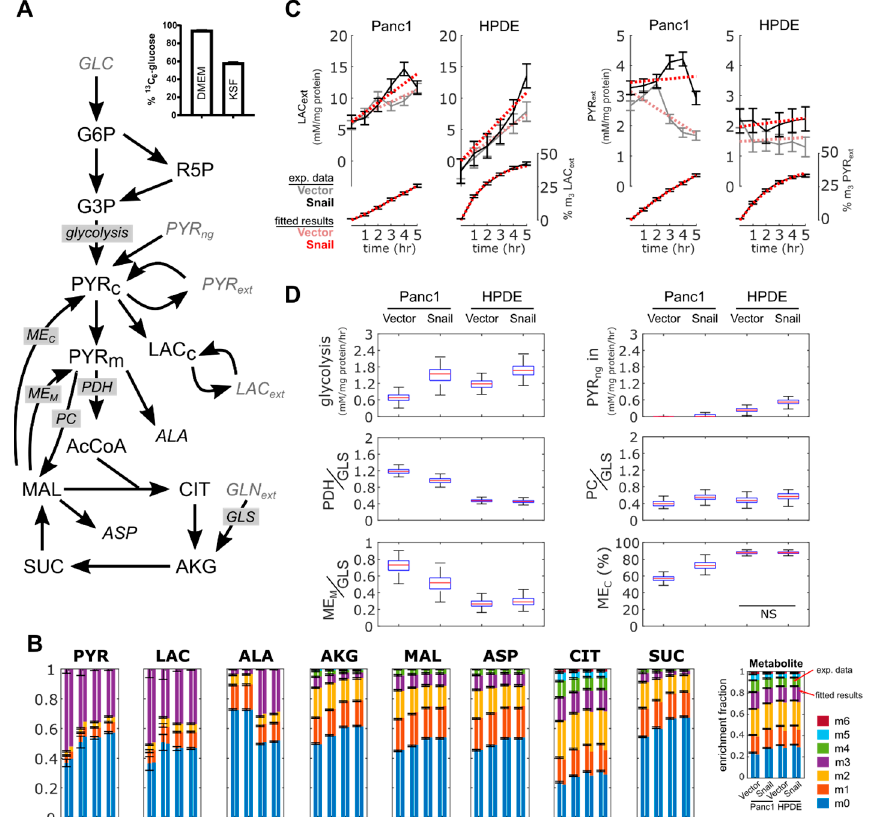
Figure 6. Metabolomics and flux analysis of the e ff ects of Snail overexpression on glucose metabolism in Panc1 and HPDE cells. ( A ) 13C metabolic flux analysis model used to interpret metabolite data. Input substrates shown as gray. Average glucose 13 C-enrichment in DMEM and KSF media shown to highlight di ff erences in starting label. ( B ) 13 C-enrichment of intracellular metabolites, showing measured fractional enrichments (left bars) and simulated results from the best fit (right bars). Data are shown with mean ± 1 SD with n = 3. ( C ) Abundance and 13 C-enrichment trajectories of extracellular lactate and pyruvate. “m3” represents fraction of lactate and pyruvate labelled at all three carbons. Results from the best fit are shown as red dotted lines. Error bars represent ± 1 SD. ( D ) Box-and-whiskers plots show estimated fluxes. PDH, PC and ME M fluxes normalized to glutamine uptake flux. ME C flux expressed as a fraction of total ME flux. All flux changes were significant, unless indicated otherwise. Enzyme: ME C (cytoplasmic malic enzyme), ME M (mitochondrial malic enzyme), PC (pyruvate carboxylase), GLS (glutaminase), glycolysis (pyruvate kinase), PDH (pyruvate dehydrogenase). Metabolites: PYR (pyruvate), LAC (lactate), ALA (alanine), AKG (2-oxoglutarate), MAL (malate), ASP (aspartate), CIT (citrate), SUC (succinate), R5P (ribose 5 phosphate), AcCoA (acetyl-CoA), GLN (glutamine). NS p >